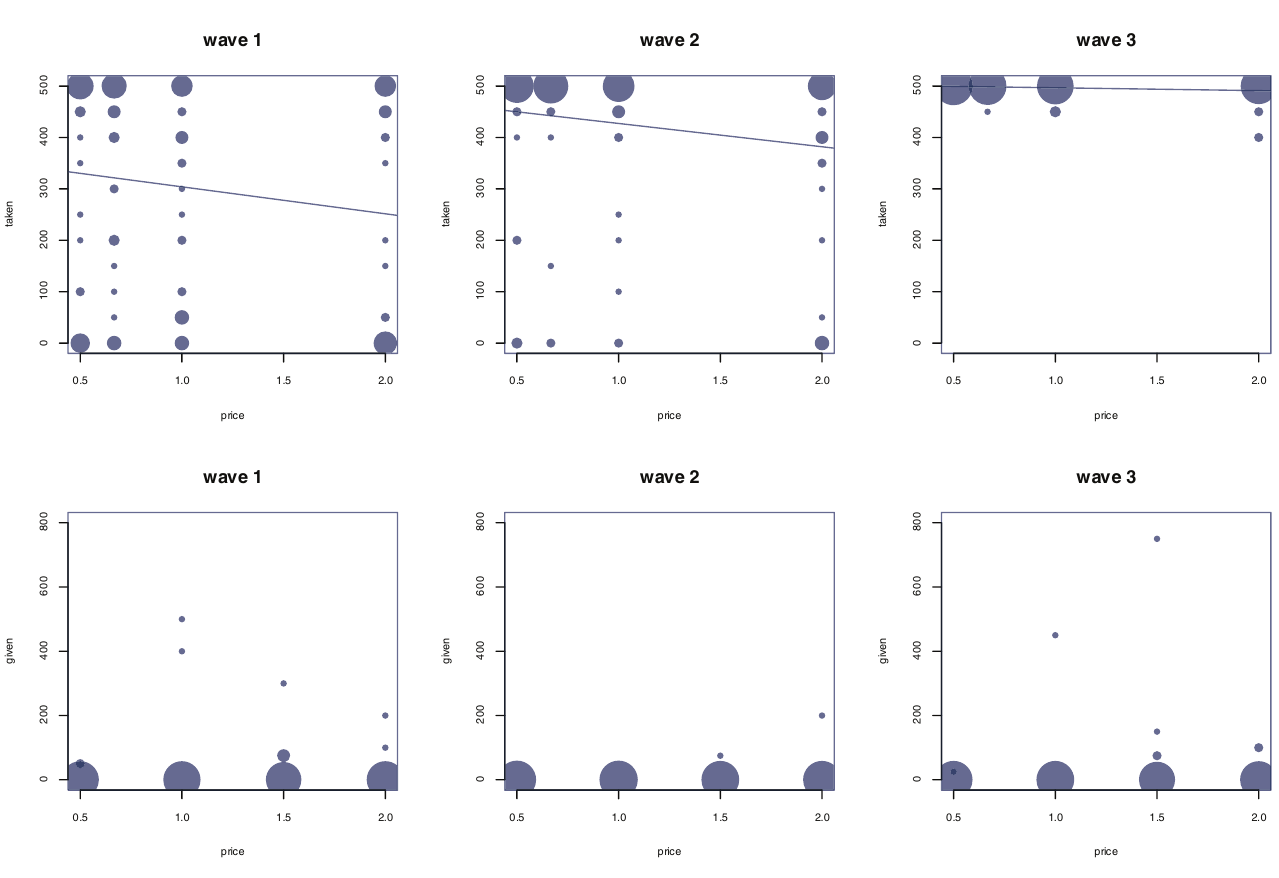
Fig 3. Amounts taken from players B in the take games (the upper 3 graphs) and amounts given to players B in the give games (the lower 3 graphs).